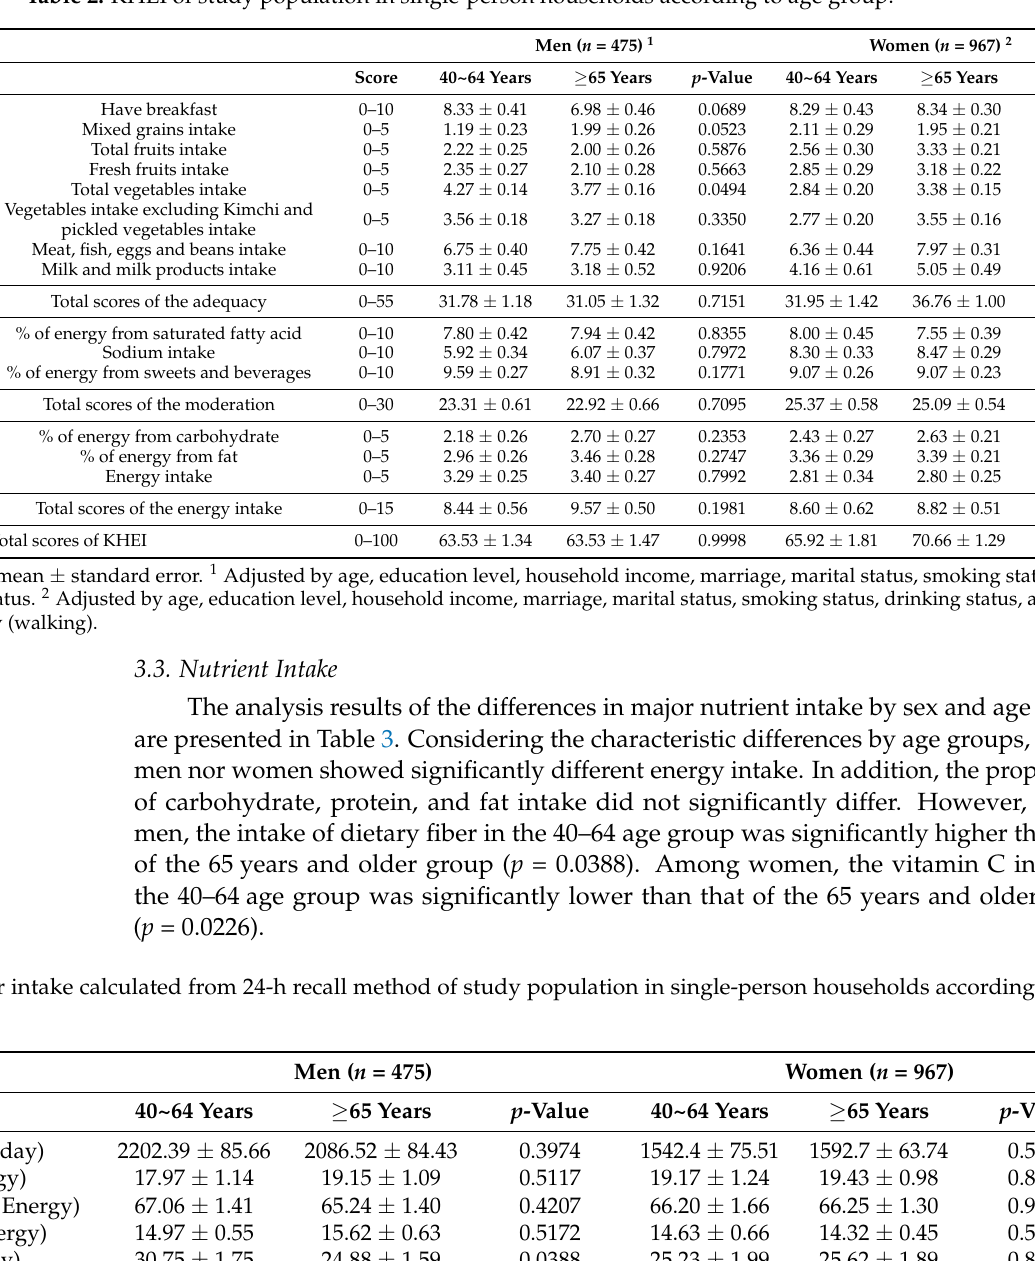
Table 2. KHEI of study population in single-person households according to age group.